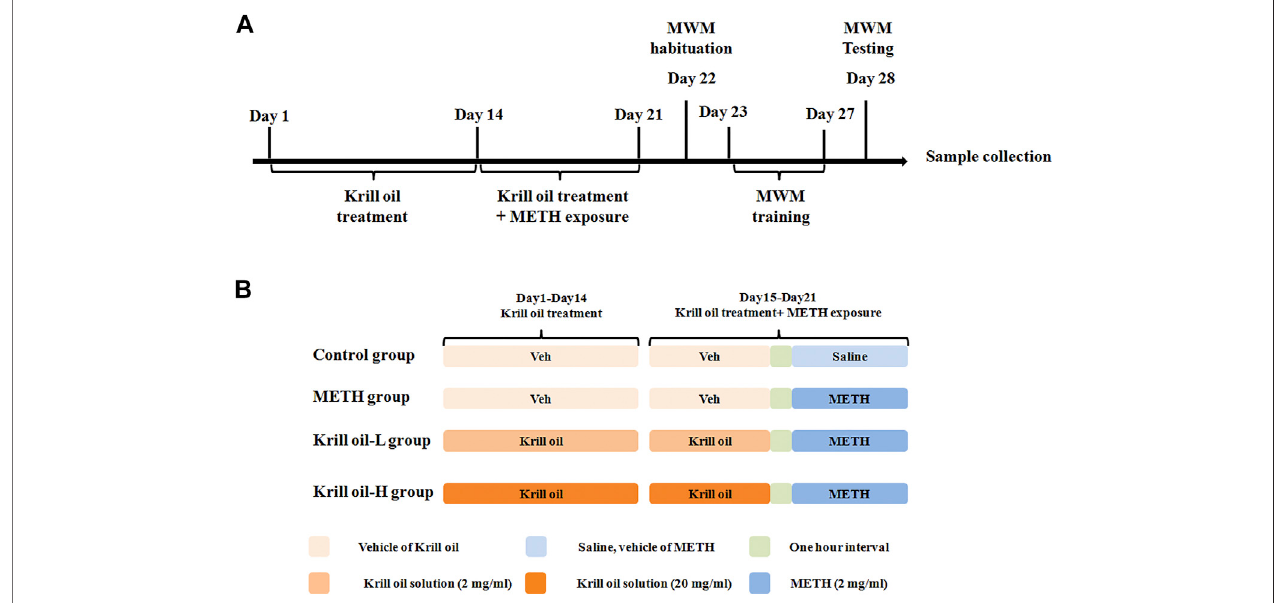
FIGURE 1 | Experimental procedure of krill oil – ameliorated memory de fi cits induced by METH. (A) For the fi rst 3 weeks, mice were administrated with different dosesofkrilloilwithorwithoutMETH.Afterthat,thebehavioraltestsandWesternblottingexperimentswereperformed. (B) Drugtreatmentoftheanimalexperiment.For the fi rst 2 weeks, mice were intragastrically administrated with different doses of krill oil or vehicle. At the third week, 1 h after the intragastric administration, mice were intraperitoneally injected with METH or saline.